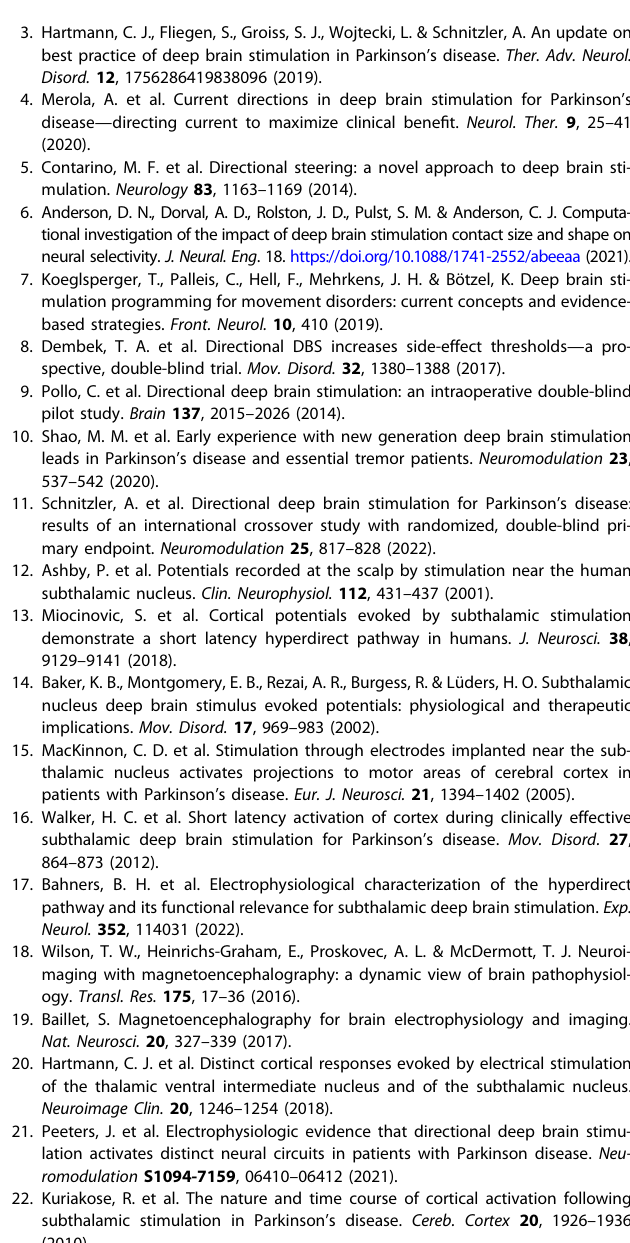
Fig. 5 STN-DBS contact orientations. a Schematic of Abbott In fi nity DBS electrode with directional (i.e., anterior, medial, lateral) and ring- shaped contact designations (i.e., omni-directional) con fi rmed anatomically using patient x-rays, CT scans and surgical notes. b Proportion of sample ’ s clinically-effective contact orientation (in %) based on clinical settings at the time of participation. The greatest proportion of clinically-effective contact orientations were identi fi ed as omni-directional and laterally-oriented contacts (>76% of the